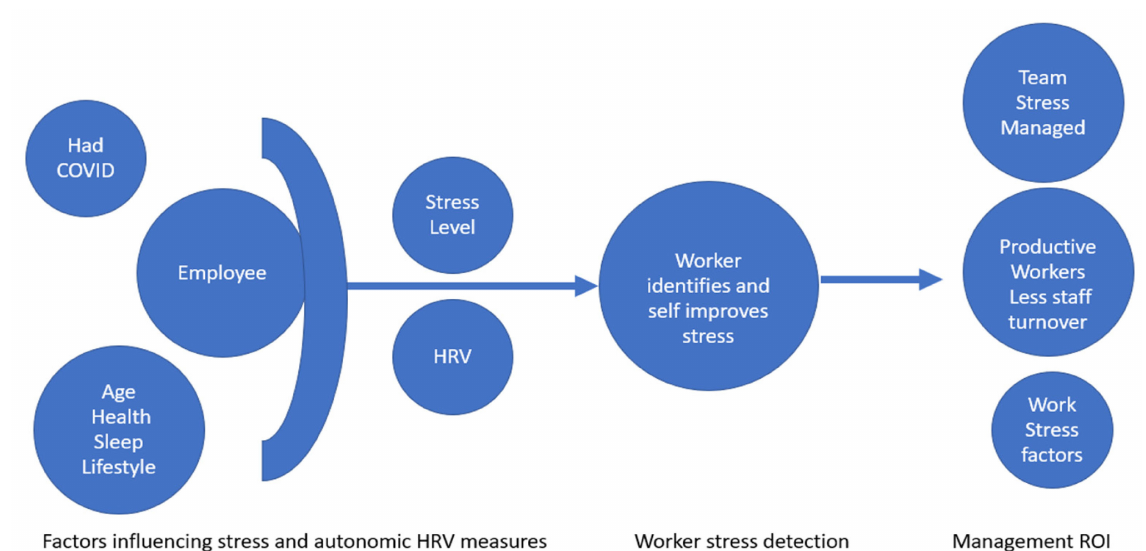
Figure 3. Conceptual model on key factors that would serve corporations tracking stress with HRV and modifying factors that may create excess noise in system. Return on Investment